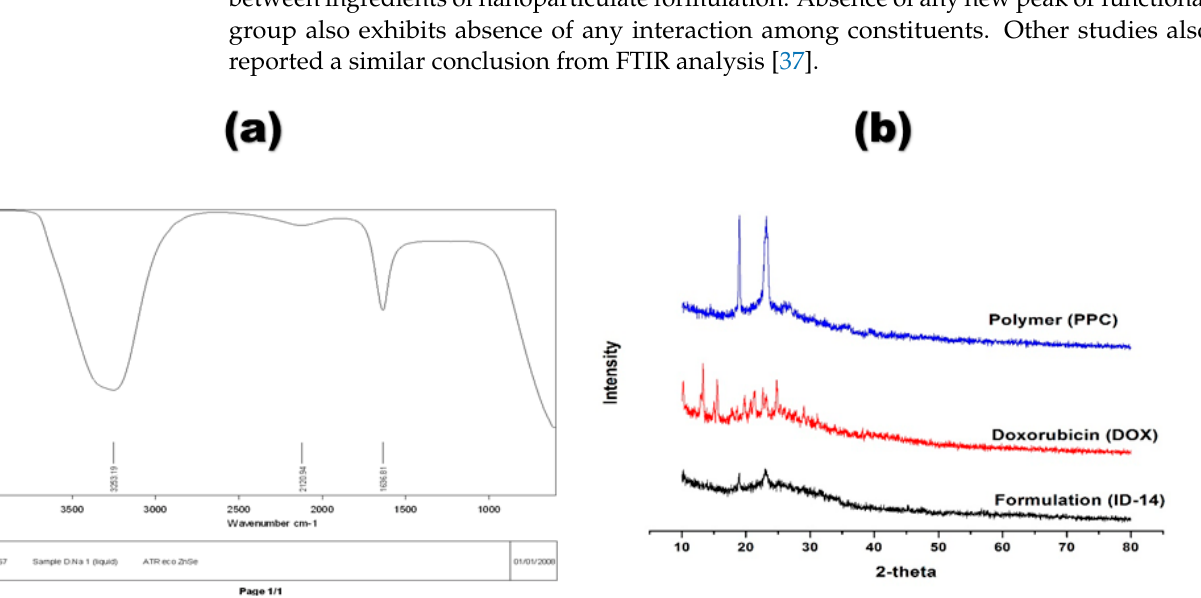
Figure 4. ( a ) FTIR spectrum and ( b ) XRD analysis of optimized